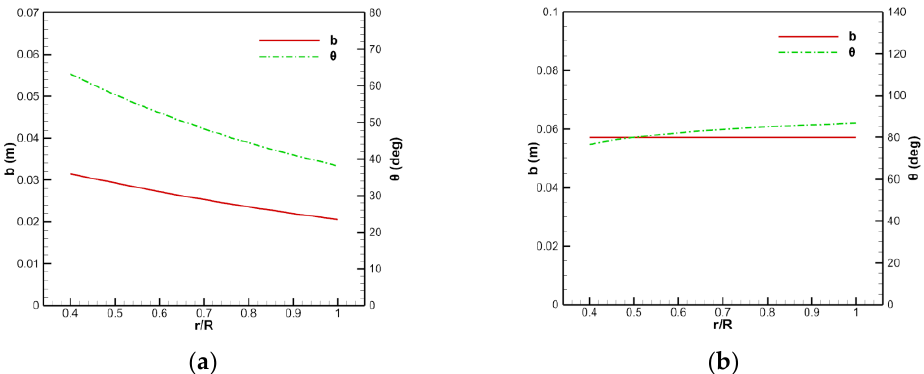
Figure 10. Design results of the chord length and torsion angle of the blade: ( a ) Rotor, ( b ) stator.